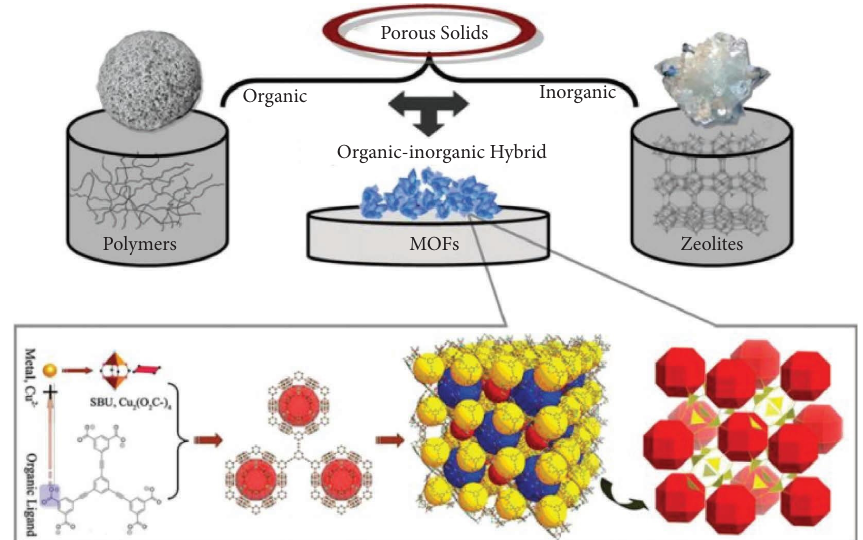
Figure 1: Some common porous materials polymers for porous organic frameworks, zeolites for porous inorganic frameworks and MOFs for porous organic-inorganic hybrid materials are adopted from